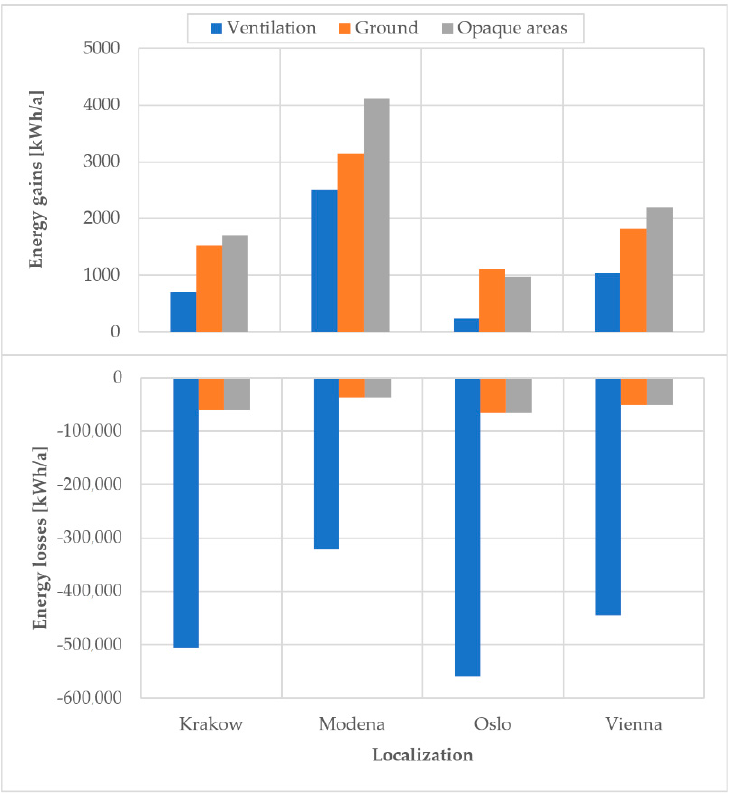
Figure 11. The balance of energy flowing through the envelope, the ground, and the ventilation system in the studied building depending on its location.